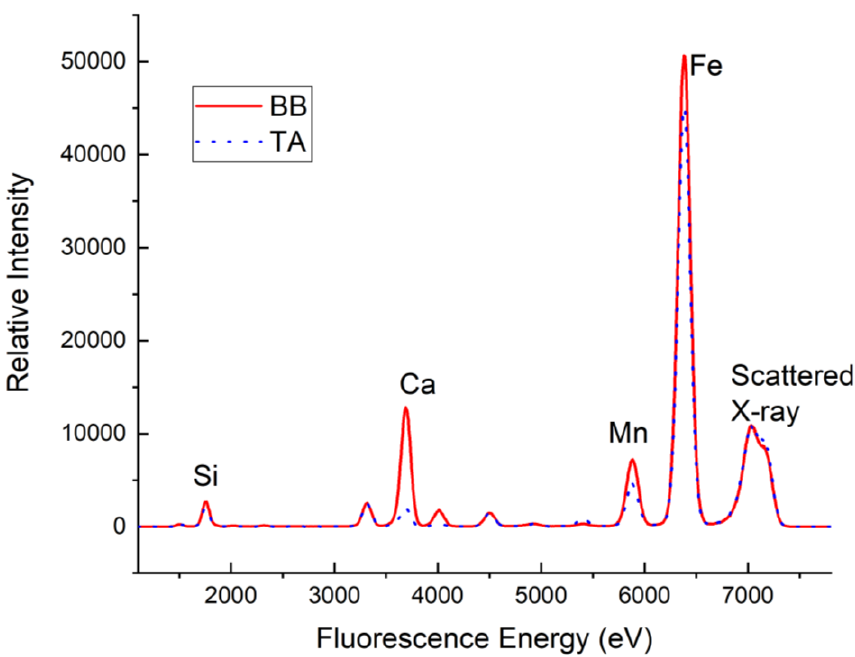
Figure 4. X-ray fluorescence spectra of bulk TA and BB sediments. The intensity was calibrated relative to the scattered X-ray (to an intensity of 10000 at 7000 eV), so that the comparison of elemental intensities is possible. The incident photon energy is 7200 eV.